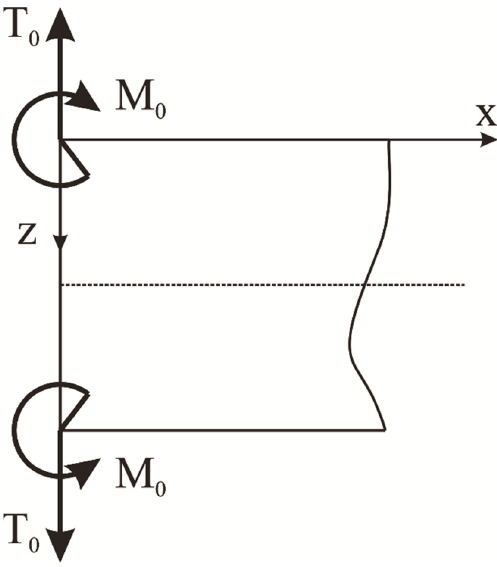
Figure 4. Boundary conditions .